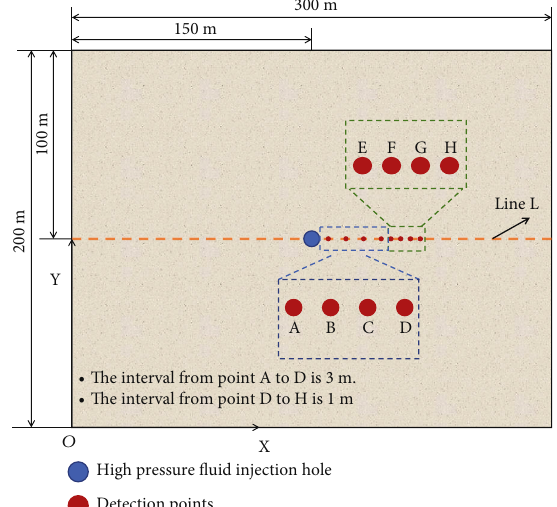
Figure 1: Detection points arrangement of the computational model. Line L: a virtual straight line along which the eight detection points (A to H) are arranged.